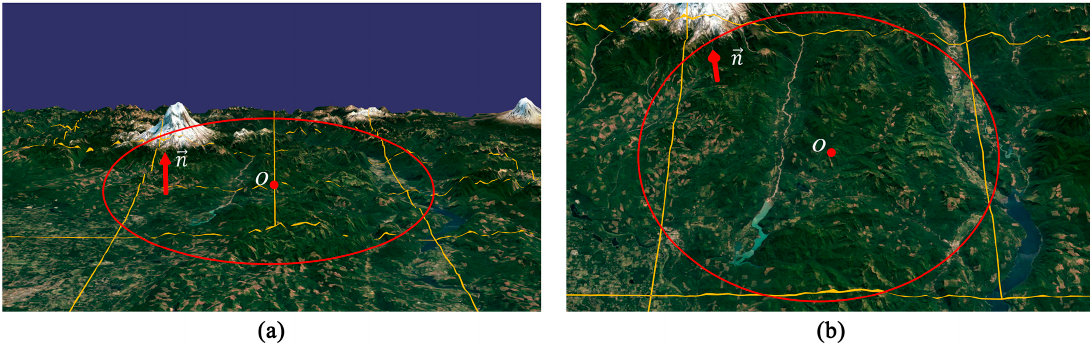
Figure 13. E ff ect of view direction change (height map size: 1025 × 1025; ρ thr : 1.0): ( a ) Four M-blocks in the red circle. ( b ) The four M-blocks in ( a ) are replaced by its parent node.